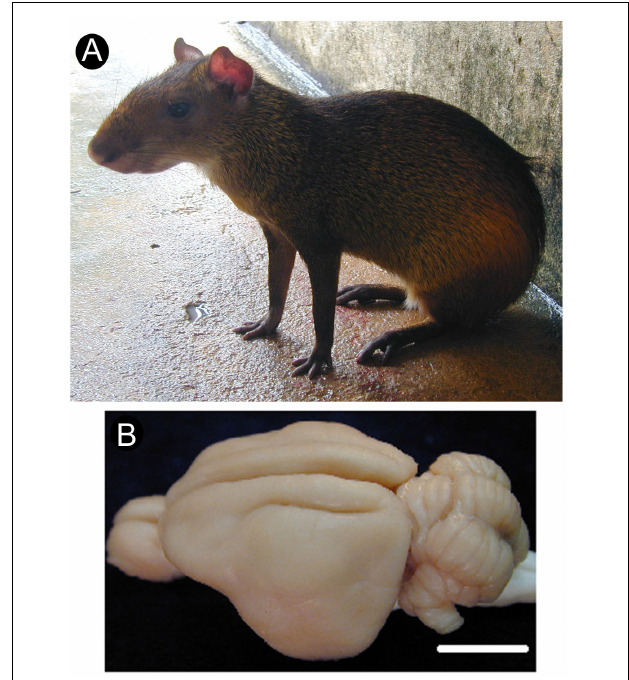
FIGURE 1 | Agouti in its typical feeding posture, sitting on its hindlimbs (A) . Dorsolateral view of the agouti’s brain with its lisencephalic aspect (B) . Scale bar: 1